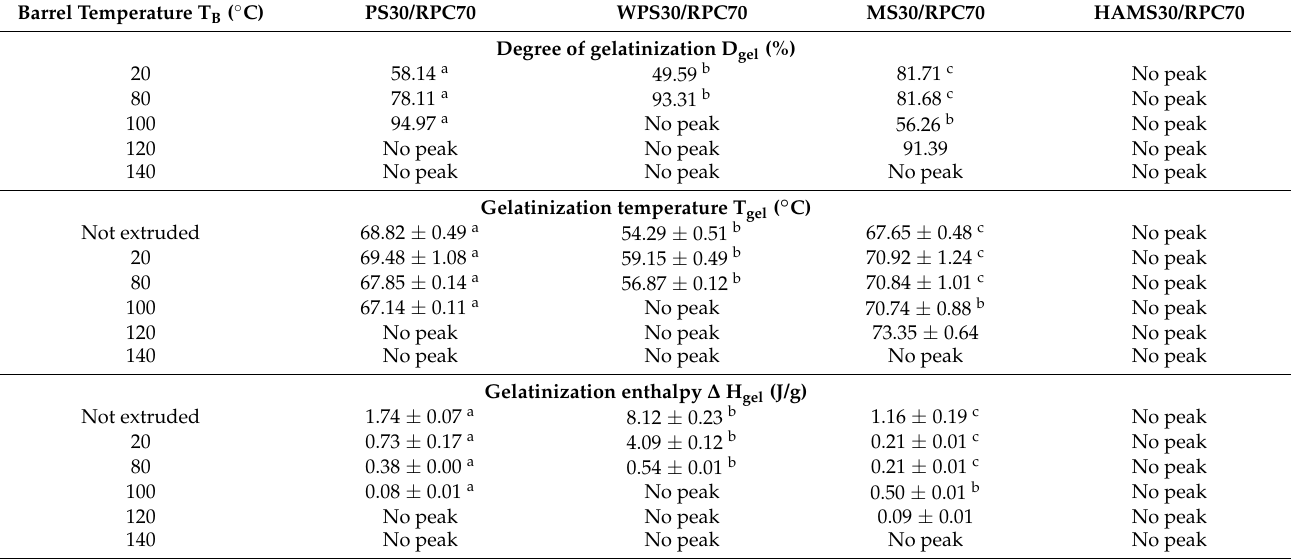
Table 4. Degree of gelatinization D gel , gelatinization temperature T gel and gelatinization enthalpy ∆ H gel of 70 g/100 g rapeseed press cake (RPC) combined with 30 g/100 g potato starch (PS), waxy potato starch (WPS), maize starch (MS) and high-amylose maize starch